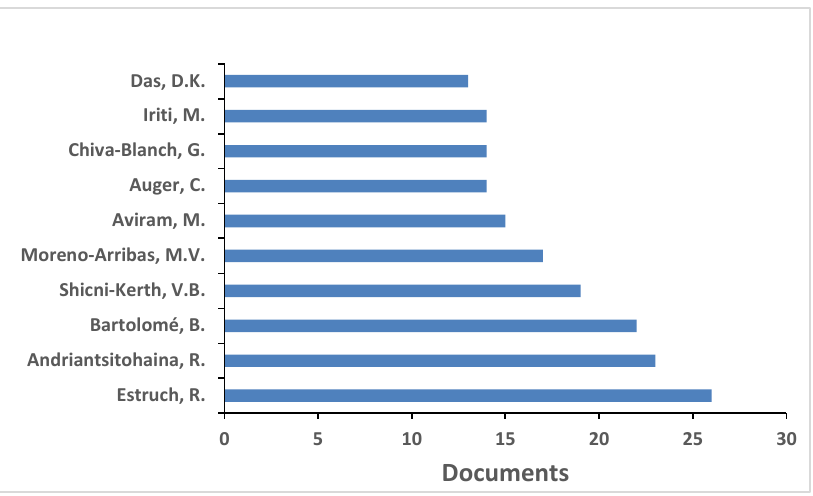
Figure 4. Most productive authors. (Bibliometric data were extracted from the Scopus online data- base).